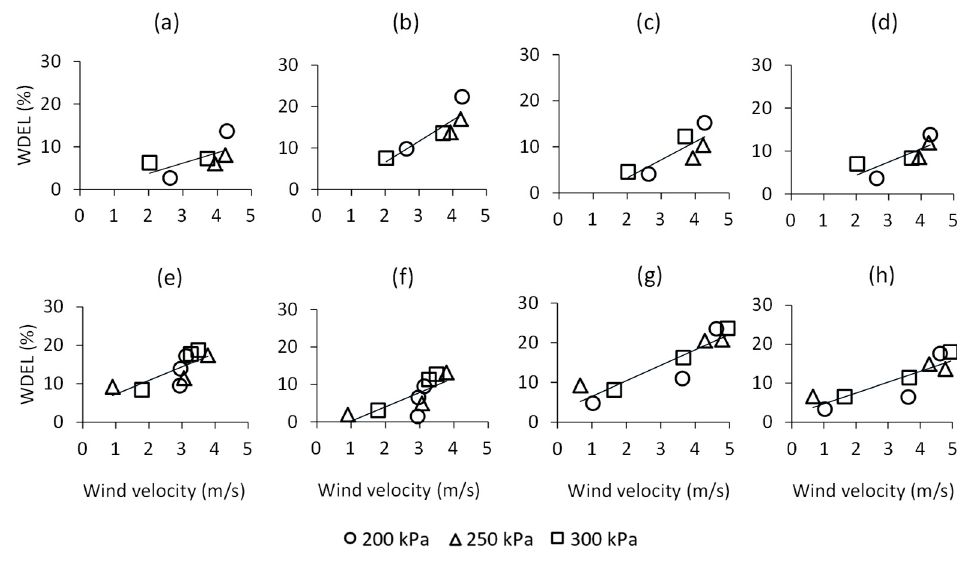
Figure 7. Wind drift and evaporation losses for the impact sprinkler analyzed, for all the experimental tests of wind velocity and operating pressure.